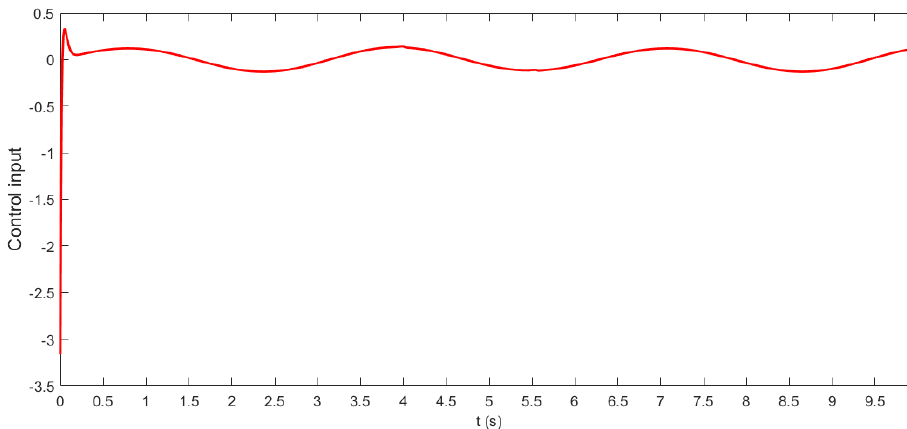
Figure 8. Control input curve.